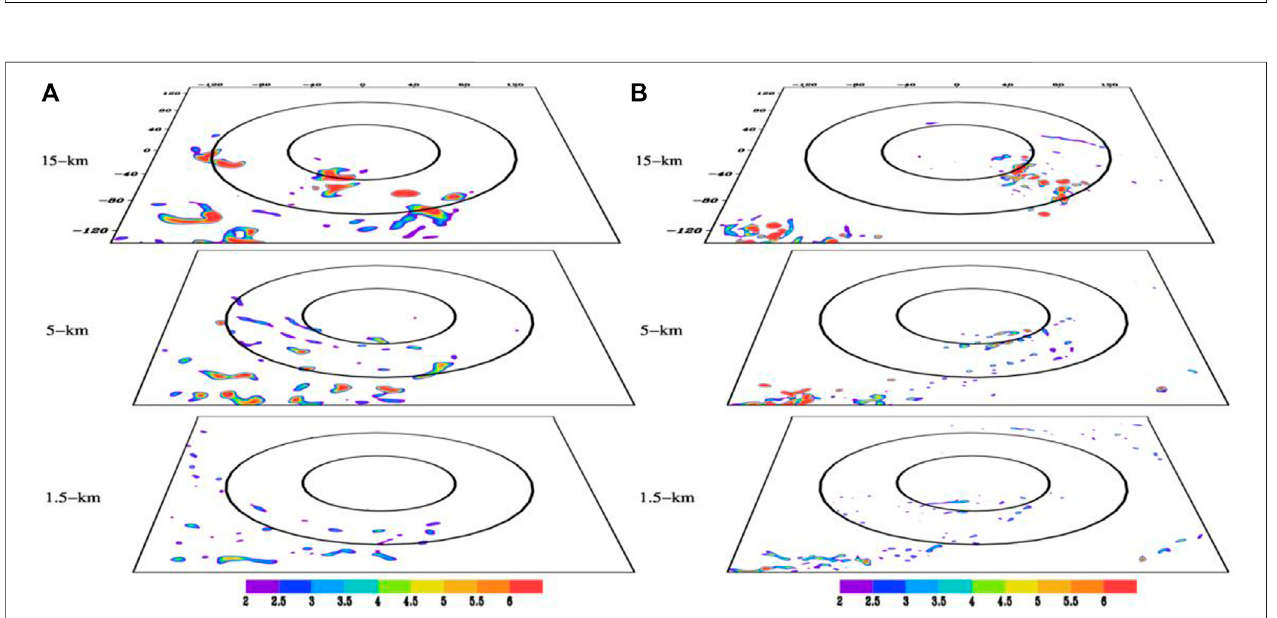
FIGURE3| Thetwosnapshotsofthecomposedlayersofverticalvelocity fi eld(units:m s − 1 )attheheightof1.5,5,and15kminCTLon06UTC06and00UTC07 August, respectively. Black circles are radii at every 50 km.